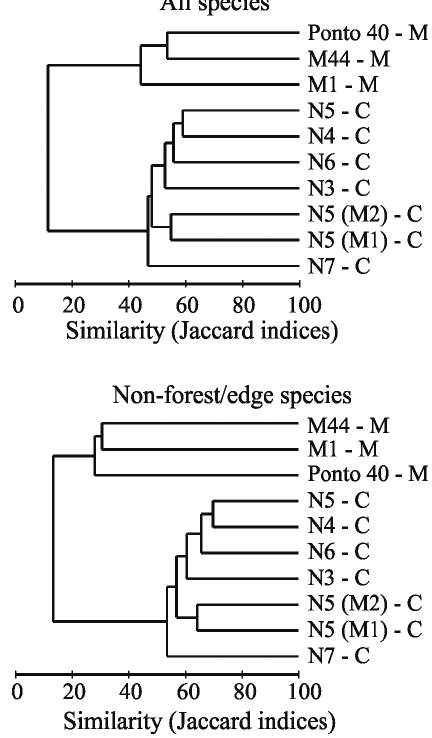
Figure 4 - Similarity dendrograms of sampled sites in cangas and forest vegetation at Carajás National Forest based in all species and only non-forest/edge bird